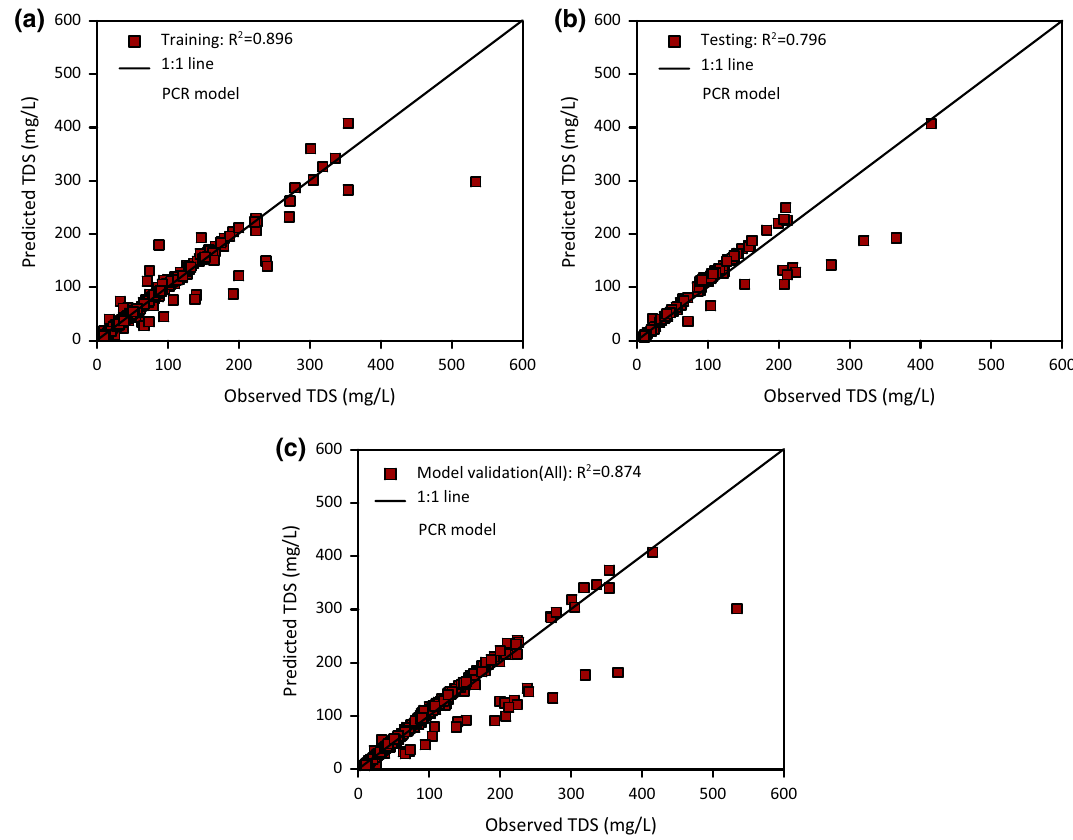
Fig. 7 Prediction accuracy of PCR model for: a training; b testing; and c